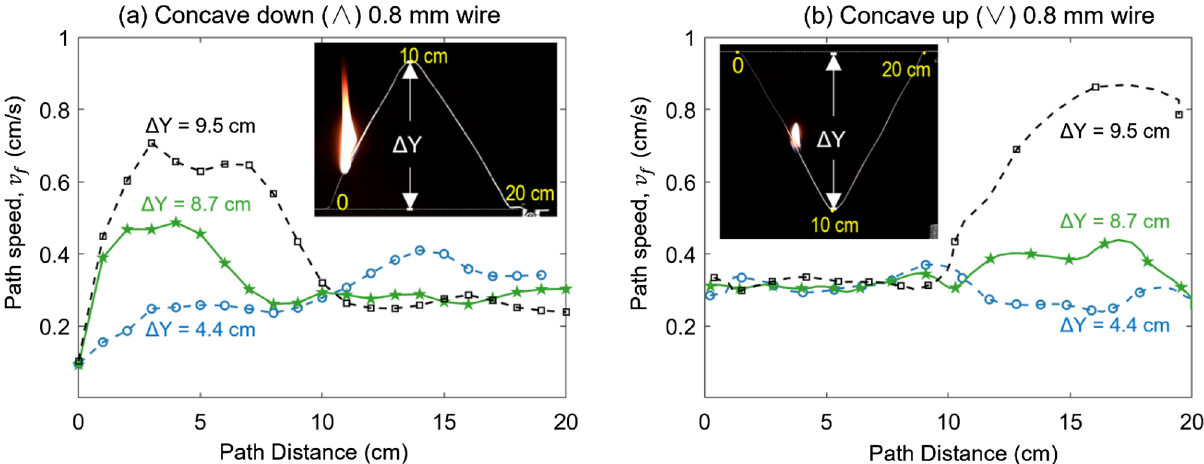
Figure 3. The local speed rate ( v f ) of ( a ) concave-down “ ∧ ” curve and ( b ) concave-up “ ∨ ” curve in the isosceles triangle